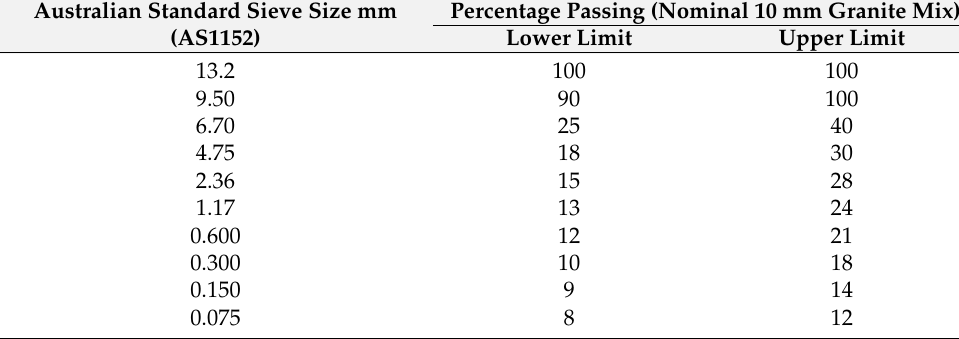
Table 3. Aggregate grade for SMA10 from MRWA Specification 502 Reprinted from ref. [4].